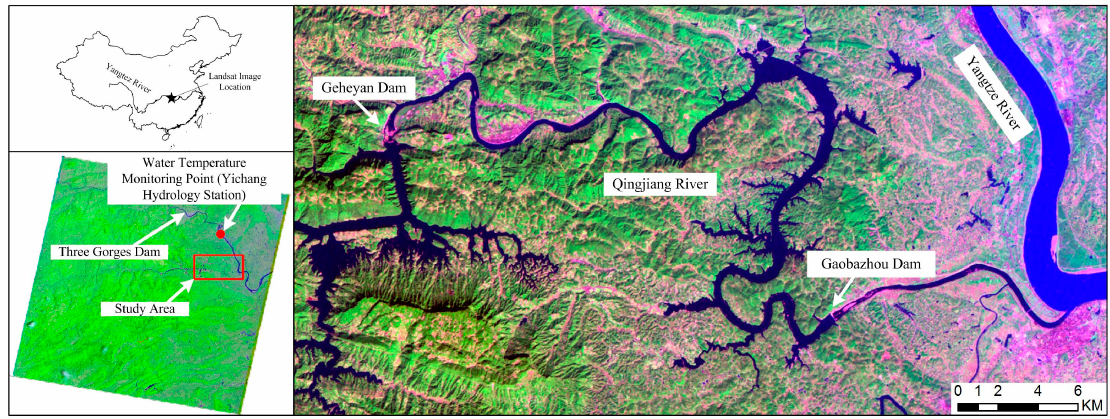
Figure 1. Study area (Qingjiang River watershed in central China) and locations of dams analyzed in this study.